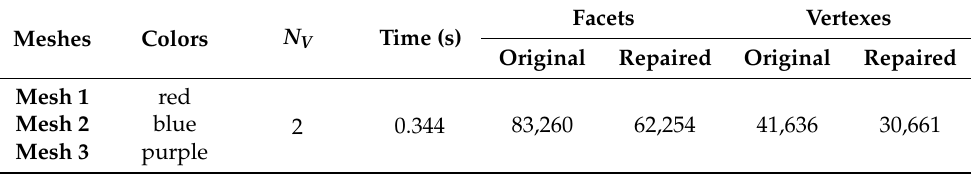
Table 2. Parameters of the multi-labeled mesh with input three sub-meshes. N V is the number of voids, the Time is the time consumed in repairing the mesh, the Facets is the number of the triangular facets in multi-labeled mesh, the Vertexes is the number of mesh vertexes in multi-labeled mesh.